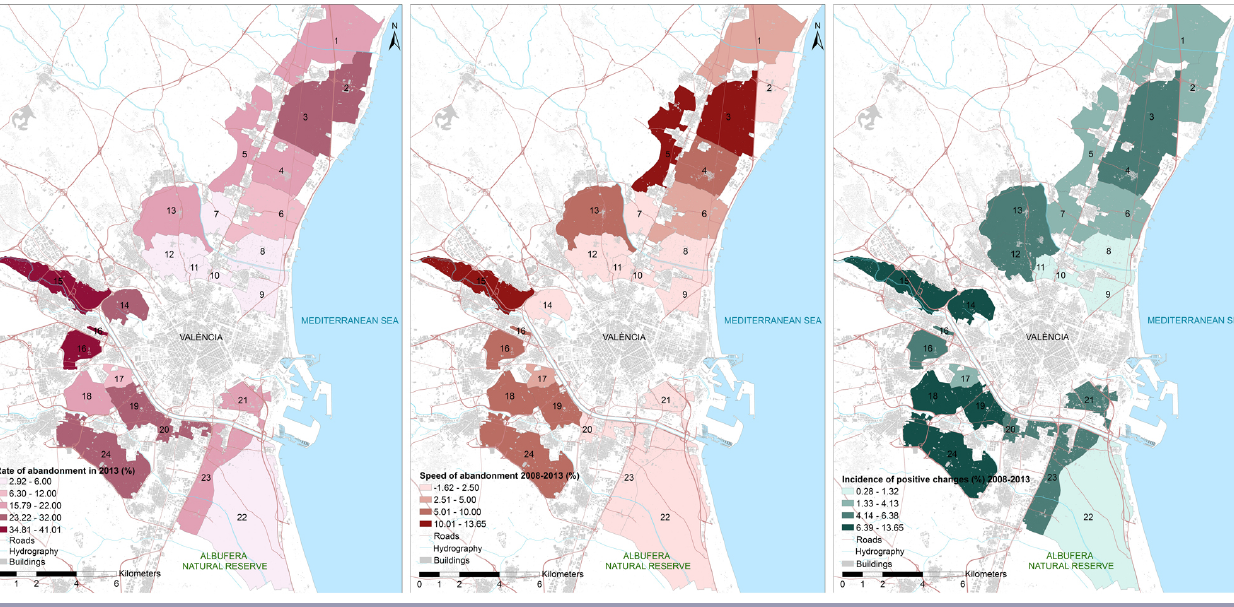
Fig. 2. Maps showing the rate and speed of abandonment and incidence of positive changes for the landscape character areas in Huerta de